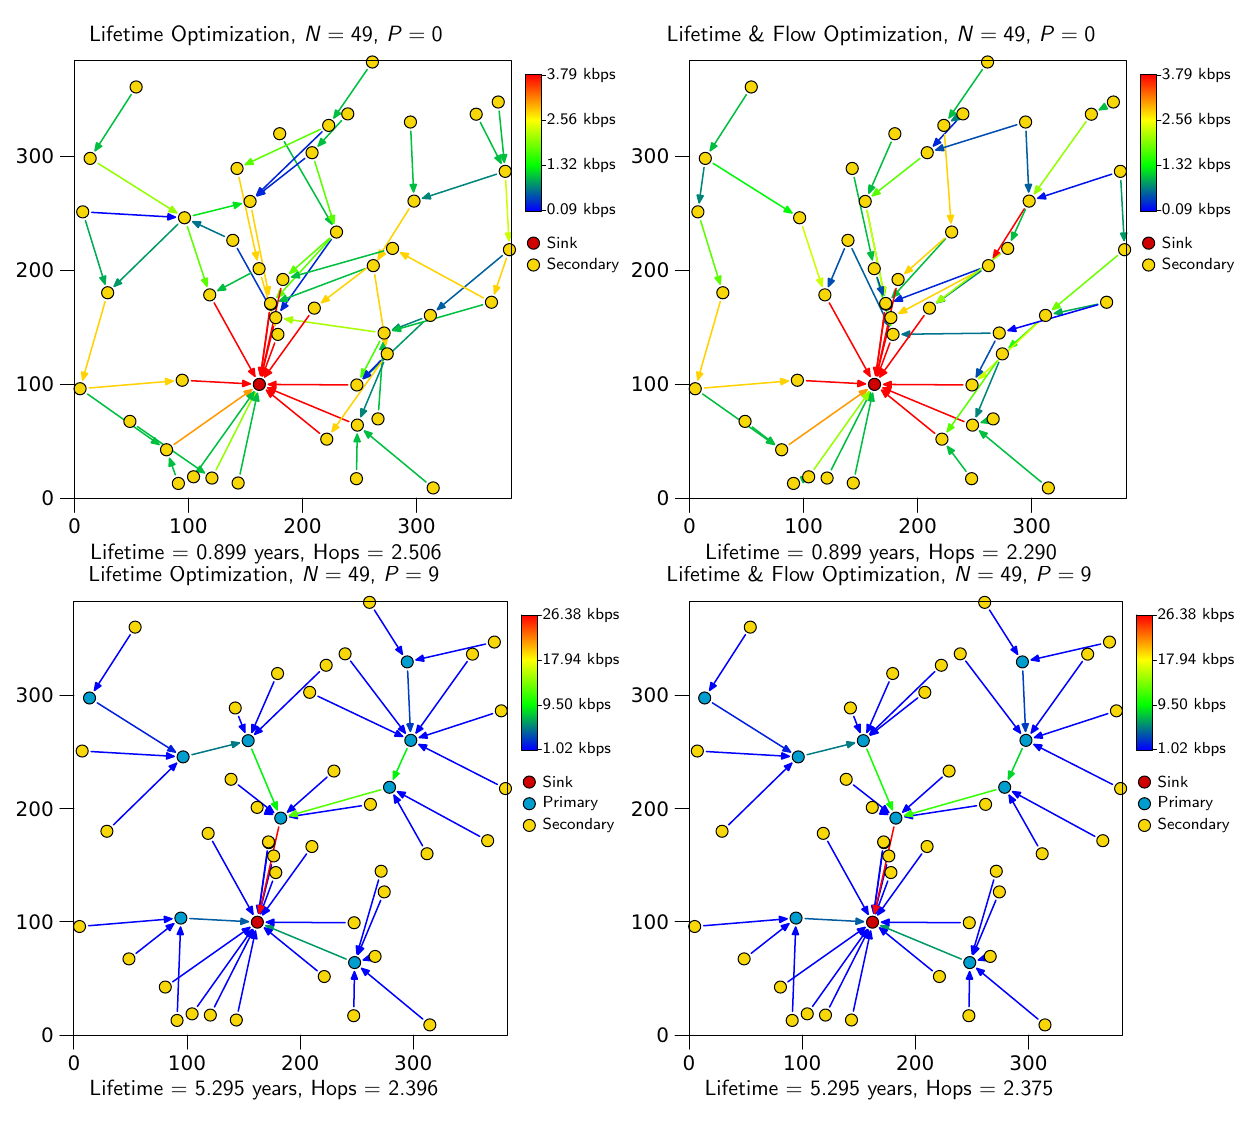
Figure 6. Example network of 49 nodes. Lifetime optimization without primary nodes. Top-right: lifetime and flow optimization without primary nodes. Bottom-left: lifetime optimization with nine primary nodes. Bottom-right: lifetime and flow optimization with nine primary